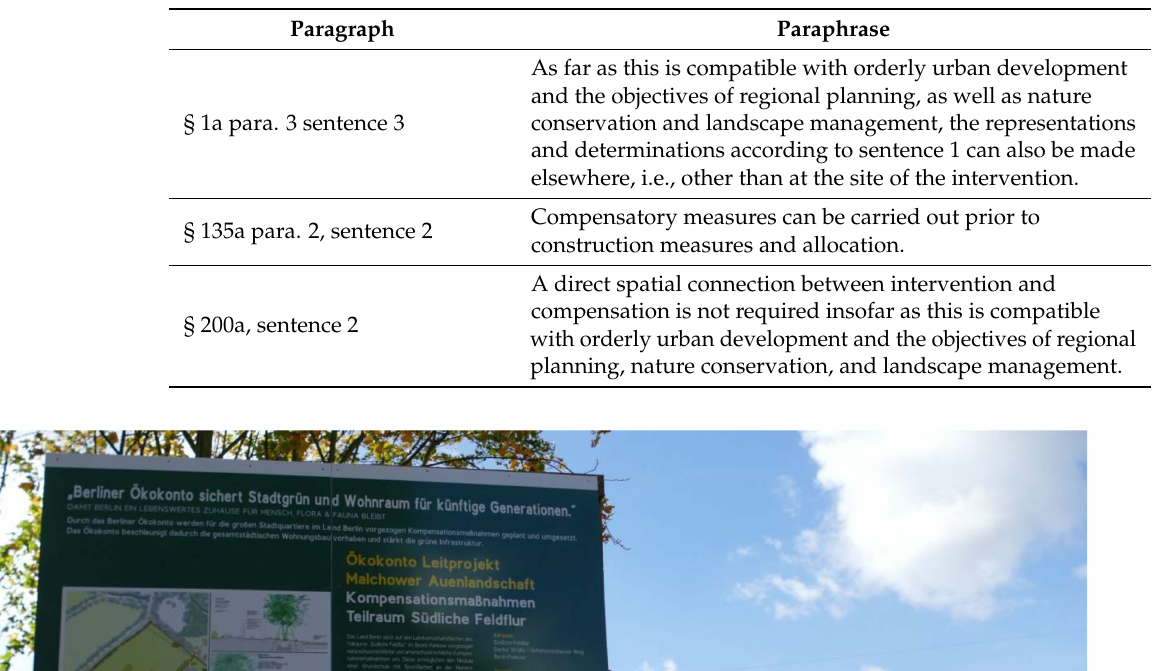
Table A2. Legal basis for LUP-EA in the Federal Building Code [43] (p. 10), [85].